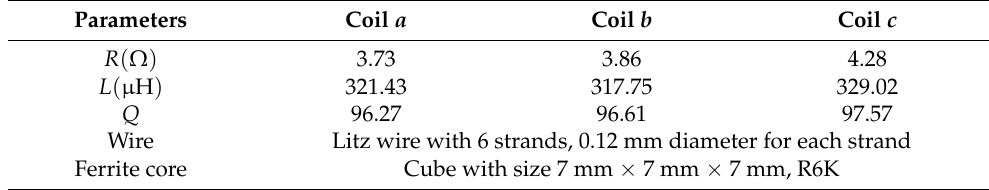
Table 1. Design parameters of the 3D receiving coil.